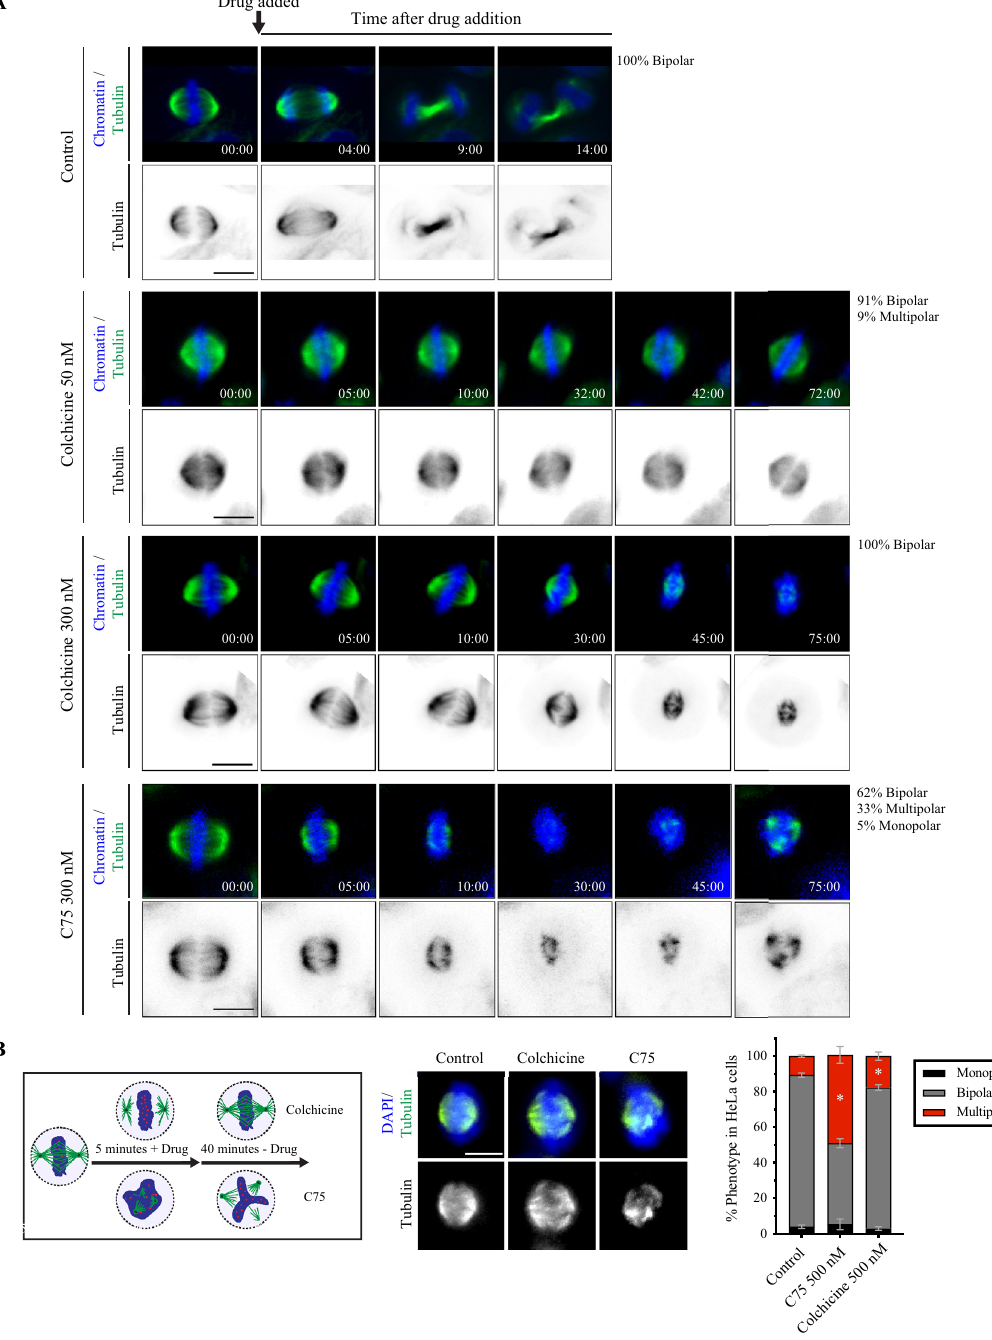
Figure 4. C75 and colchicine cause different spindle phenotypes. ( A ) Timelapse images show live HeLa cells co-stained for DNA (Hoechst 33,342; blue) and microtubules (SiR-tubulin; green). Times are indicated in minutes. An arrow points to the time of addition of DMSO (control; n = 15), 50 nM colchicine (n = 33), 300 nM colchicine (n = 20) or 300 nM of C75 (n = 21) to cells. The proportion of cells with bipolar, multipolar or monopolar spindles are indicated. ( B) A cartoon schematic shows how HeLa cells were treated with drug (DMSO, 500 nM C75 or colchicine) for 5 min, then fixed 40 min after the drugs were washed out. Underneath, images show fixed HeLa cells co-stained for DNA (DAPI; blue) and tubulin (green or white) after treatment with C75 or colchicine. To the right, a bar graph shows the proportion of cells with monopolar (black), bipolar (dark grey) or multipolar (red) spindles. Bars show standard deviation and asterisks indicate p < 0.05 by multiple t tests vs. control. The scale bar for all cells is 10